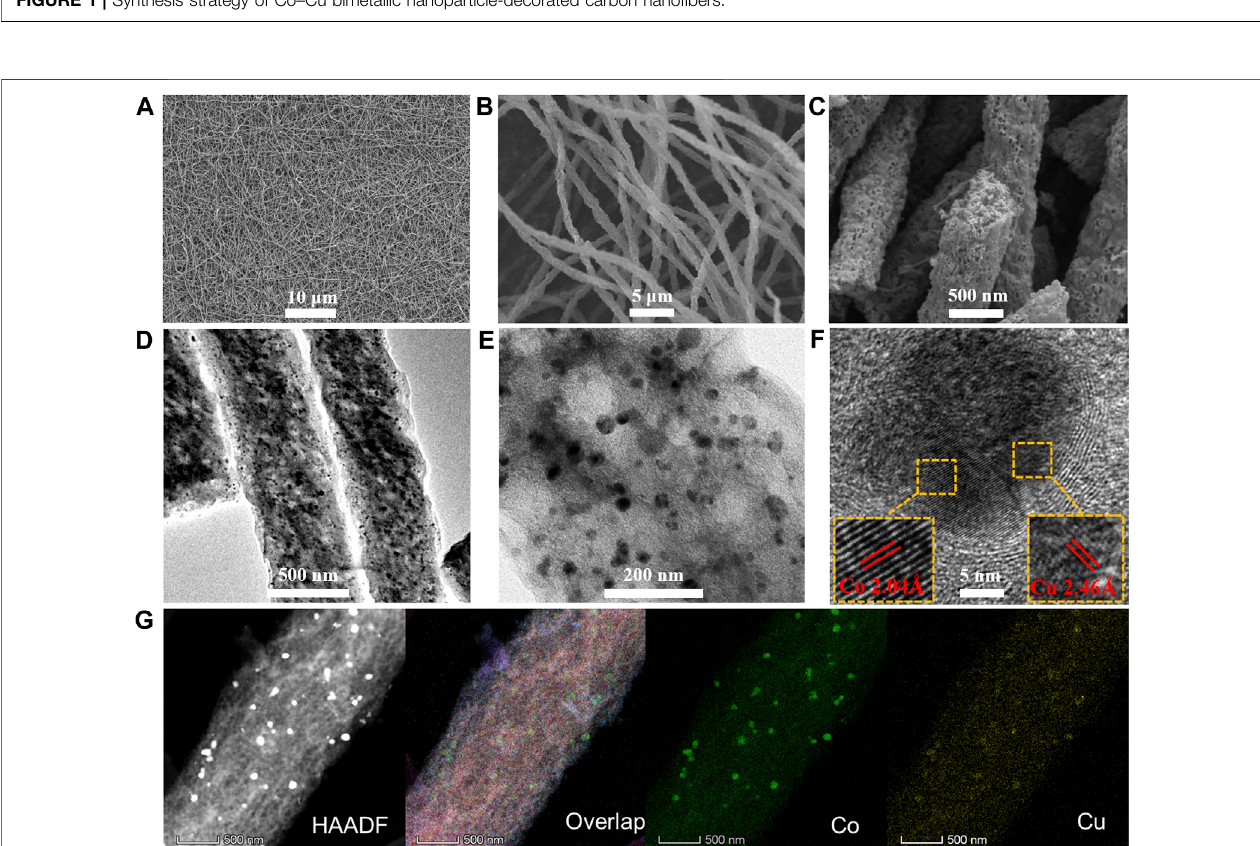
FIGURE 2 | (A – C) SEM and (D – E) TEM images with different resolutions of Co fringes of Co and Cu; (G) HAADF-STEM and elemental mapping images of Co 3 Cu/CFs.